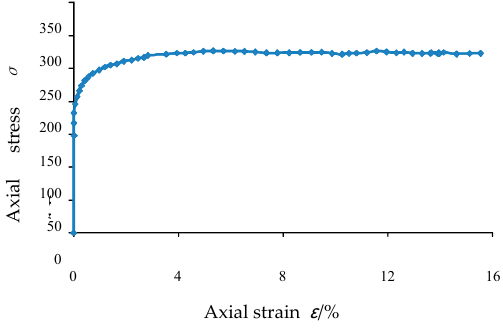
Figure 15. Axial stress-strain curve in plane strain test with 150 kPa confining pressure.